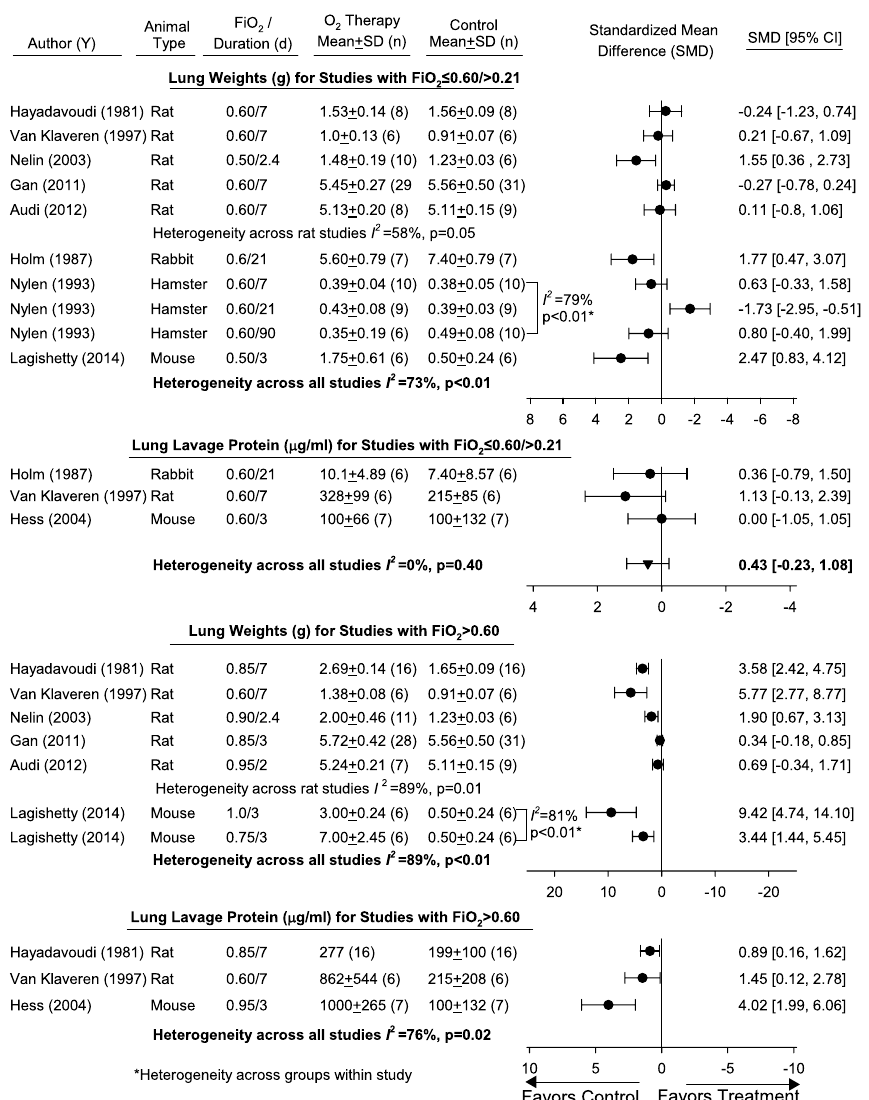
Fig. 5 Effects of FiO 2 s 0.60 and > O.21 (FiO 2 0.60/ > O.21) (Panel A ) or FiO 2 s > 0.60 (Panel B ) vs. FiO 2 s 0.21 ≤ ≤ = (controls) on standardized mean differences ( SD) (SMD) in two measures of lung injury, lung weight and ± lung lavage protein concentration, in studies [author (y)] that did not include an infectious or noninfectious inflammatory challenge. Animal type and increased FiO 2 level and duration employed in studies and groups are shown. Also shown for each study or group are the standardized means ( SD) and numbers of animals ± ( n ) used to calculate individual SMDs. Data from studies used to calculate SMDs for these parameters and parameter units are shown in Additional file 1: Table S7. Analysis for two studies (Nylen and Lagishetty) that included more than one regimen of FiO 2 0.60/ > O.21 or FiO 2 > 0.60 showed that the level of significance ≤ for heterogeneity across these regimens prevented pooling groups ( I 2 79%, p < 0.01; I 2 81%, p < 0.01) ≥ ≥ and these are shown as solid circles and used in analysis individually here. While it was possible to calculate an overall SMD for lavage protein concentration in studies with FiO 2 0.60/ > 0.21 ( I 2 0%, p 0.40), ≤ = = heterogeneity prevented an overall calculation for lung weights for FiO 2 0.60/ > 0.21 ( I 2 73%, p < 0.01) or ≤ = for lung weights and lavage protein concentration for FiO 2 > 0.60 ( I 2 89%, p < 0.01 and I 2 76%, p 0.02, = = =